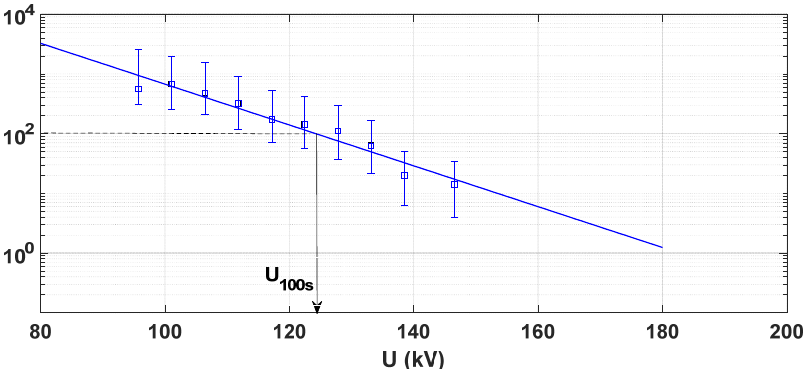
Figure 5. Mean time between breakdown as a function of the applied voltage peak for a 4 mm free particle in the concentric sphere electrode arrangement filled with 0.75 MPa CO 2 /O 2 . U 100s is the peak voltage for which the mean time between breakdowns is 100 s. The bars indicate the 95% confidence intervals.